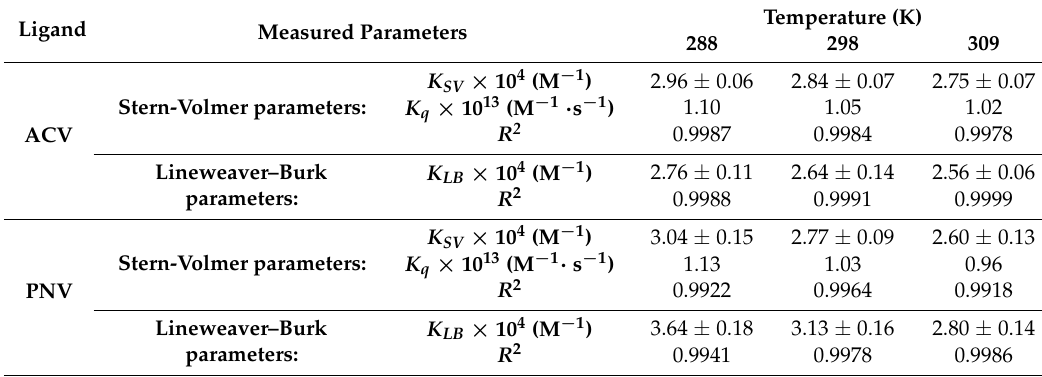
Figure 3. Stern–Volmer plots for ( a ) ACV-HSA and ( b ) PNV-HSA systems and Lineweaver–Burk plots for ( c ) ACV-HSA and ( d ) PNV-HSA systems. Table 1. Parameters computed from the Stern–Volmer and Lineweaver–Burk relations for ACV and PNV interactions with HSA.